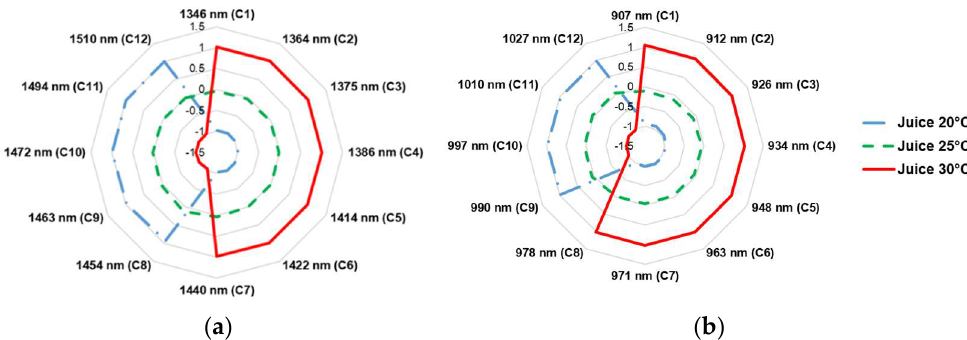
Figure 5. Aquagrams at three temperatures in ( a ) the first overtone (1300–1600 nm) ( b ) the second overtone (870–1100 nm) region of the OH stretch of water in kiwifruit juice.